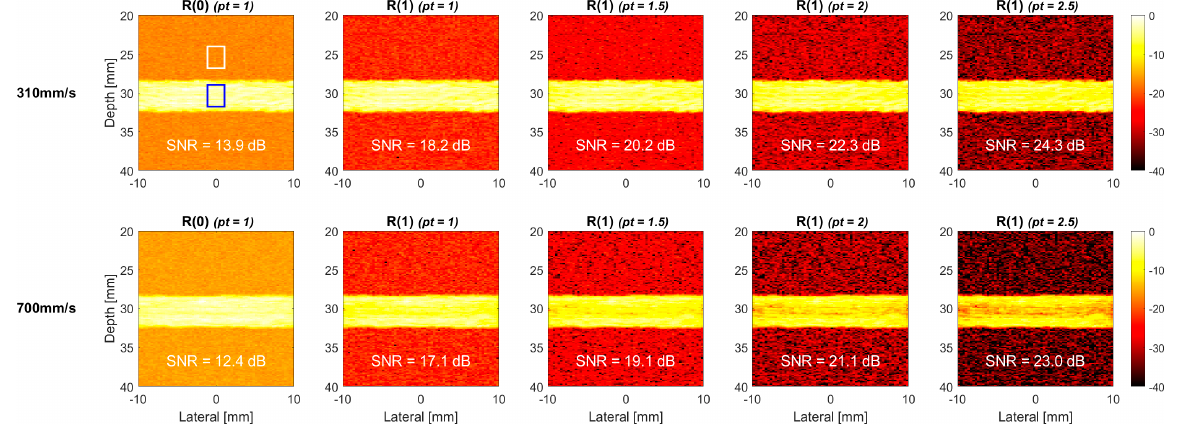
Figure 9. Simulated TMAS power Doppler images of longitudinal-view flow phantom for R(1) images with the pt values of 1.0, 1.5, 2.0 and 2.5, respectively from left to right. R(0) image is also provided as a reference. The flow velocity is 310 mm/s ( upper ) and 700 mm/s ( lower ). The inclined angle of the flow vessel is 0°.